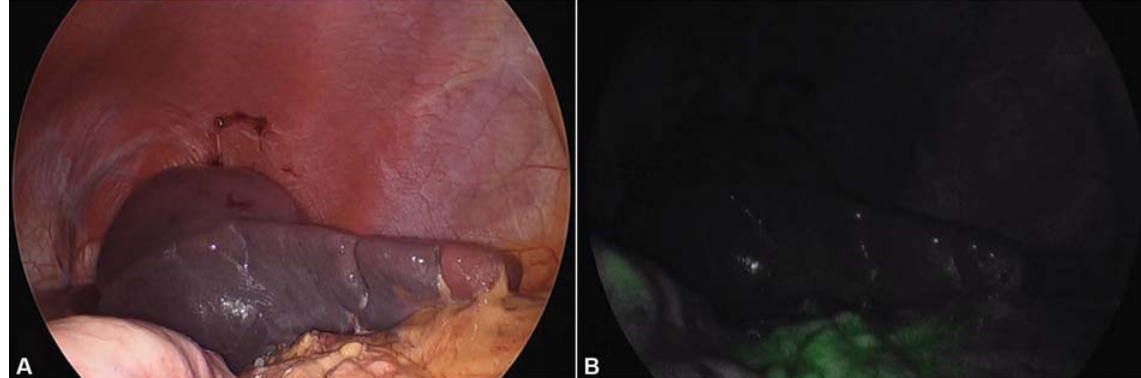
Fig. 4 Intraoperative image after venous clamping. ( A ) Image under LED light. ( B ) Image under near infrared light. No fl uorescence is observed in the inferolateral pole of the spleen, re fl ecting adequate ICG wash-out through a permeable venous system. Some ICG rests can be seen in the omentum (lower part of the image) and stomach (left edge). ICG, Indocyanine green.